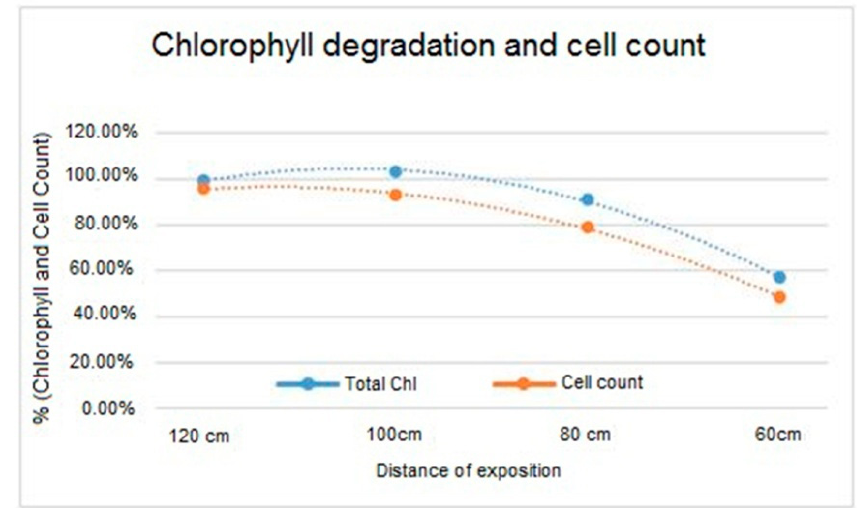
Figure 2. Total chlorophyll content and number of cells (expressed as a percentage of the maximum value obtained at the maximum distance of 120 cm) in samples subjected to UV-C treatment at different distances (120, 100, 80, 60 cm).